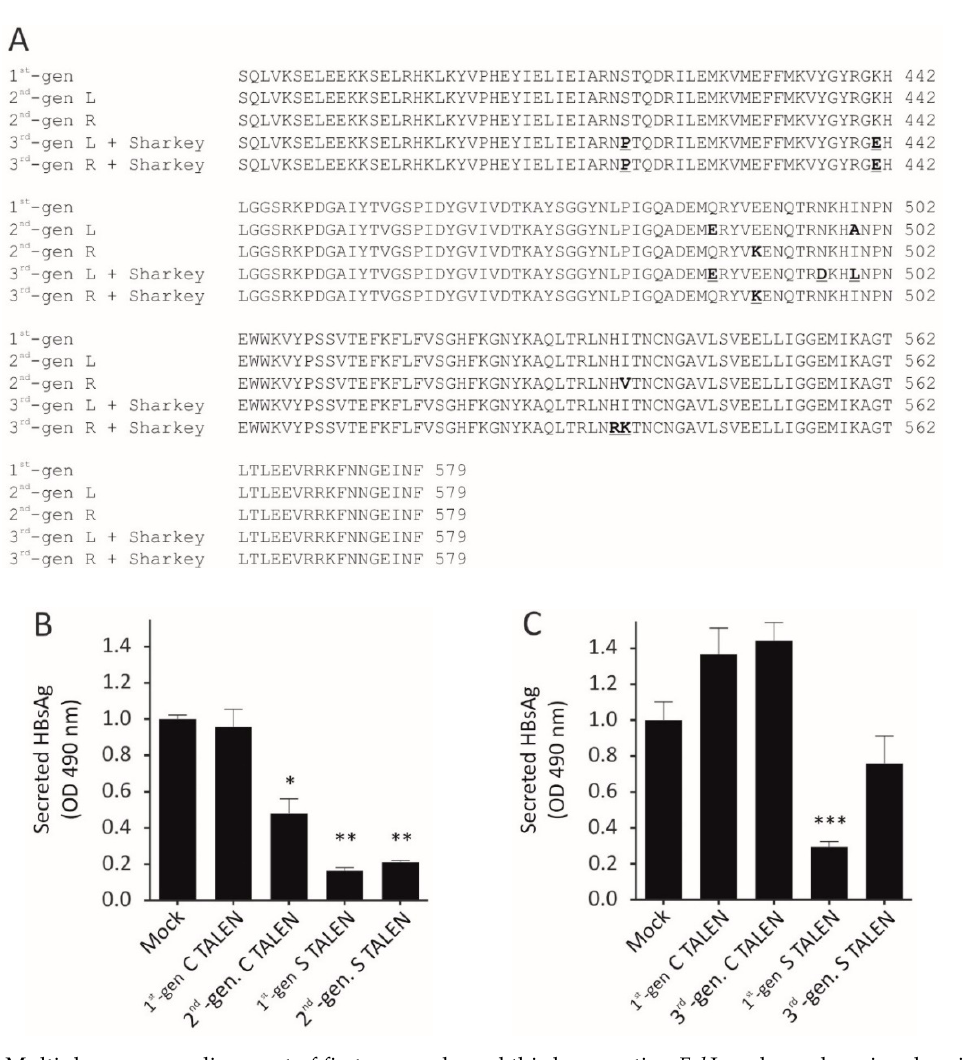
Figure 1. ( A ) Multiple sequence alignment of first-, second-, and third-generation Fok I nuclease domains showing obligate heterodimeric (bold) and Sharkey (bold and underlined) modifications. ( B ) To compare silencing efficacy of second-generation TALENs, Huh7 cells were transiently co-transfected with the pCH-9/3091 and the indicated plasmids. HBsAg was assayed 48 h after transfection. Data obtained were averaged, and the means were normalized to the mock. Statistical Scheme 0. * = p < 0.05; ** = p < 0.001; *** = p < 0.001. ( C ) As in ( B ), but comparing third-generation against anti-HBV TALENs containing the first-generation Fok I nuclease domain.